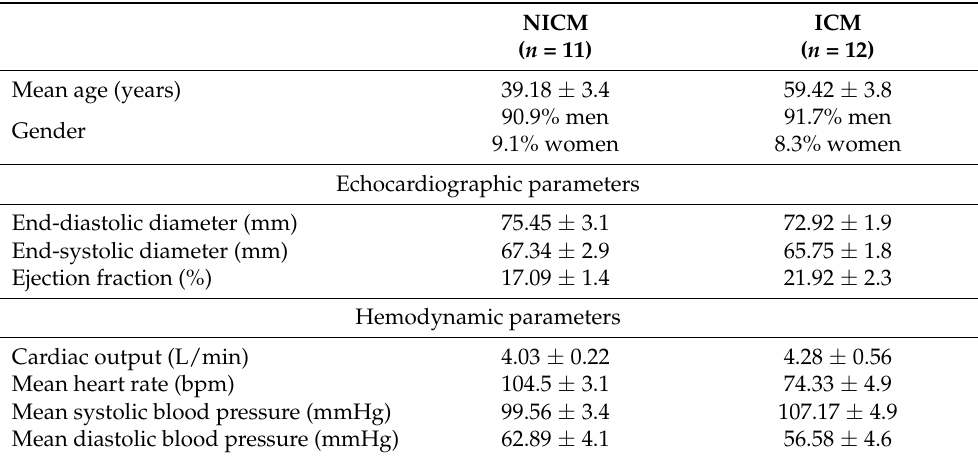
Table 4. The most important anthropometric data, echocardiographic and hemodynamic parameters of the examined patients with non-ischemic cardiomyopathy (NICM) and ischemic cardiomyopathy (ICM) before heart transplantation.